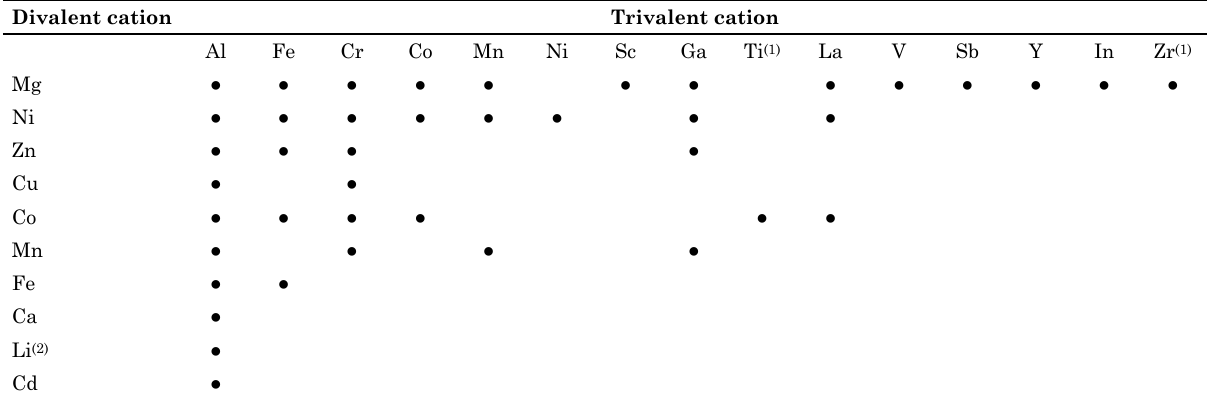
Table 1. Possible combinations of metallic cations M 2+ and M 3+ in